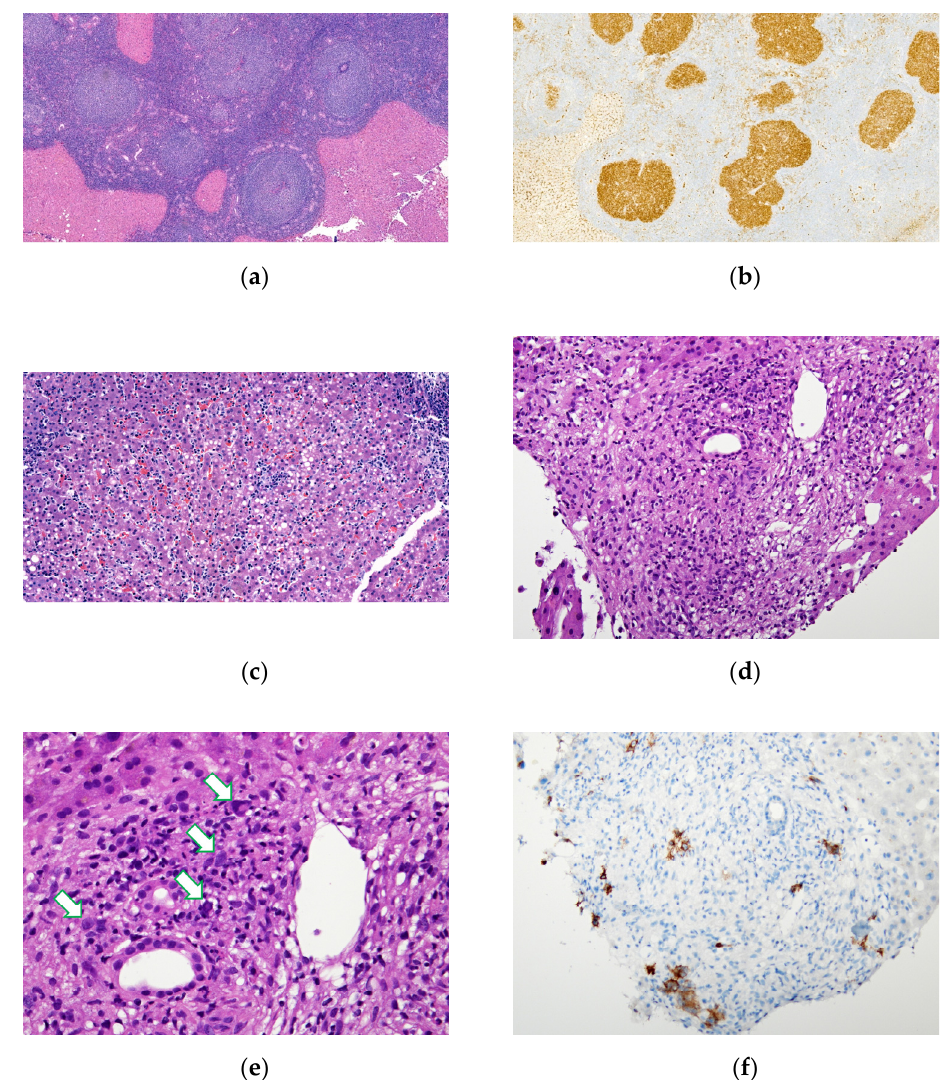
Figure 2. Variable pathologic findings in primary liver lymphoma: ( a , b ) 65-year-old male with pri- mary hepatic follicular lymphoma, same patient in Figure 1a. ( a ) Hematoxylin and Eosin (HE) stain, ×40 magnification. Resected liver parenchyma showed nodular distribution of atypical lymphoid follicles with attenuated mantle zone and loss of polarity in germinal center. ( b ) Immunohistochemistry (IHC) stain for CD10, ×40 magnification. Strong-stained pattern in germinal center. ( c ) 12-year-old male with hepatosplenic T-cell lymphoma, same patient in Figure 1c. Liver needle biopsy showed sinusoidal infiltration of atypical lymphocytes. HE stain, ×100 magnification. ( d – f ) 80-year-old male patient with secondary hepatic involvement with classical Hodgkin lymphoma. ( d ) HE stain, × 100 magnification. Needle biopsy of liver showed ill-formed granuloma over portal area. ( e ) Mummified Hodgkin cells (arrow) were barely noted in high power and masked by inflammatory cells. HE stain, ×400 magnification. ( f ) More Hodgkin cells are highlighted by CD30 IHC stain, ×100 magnification.